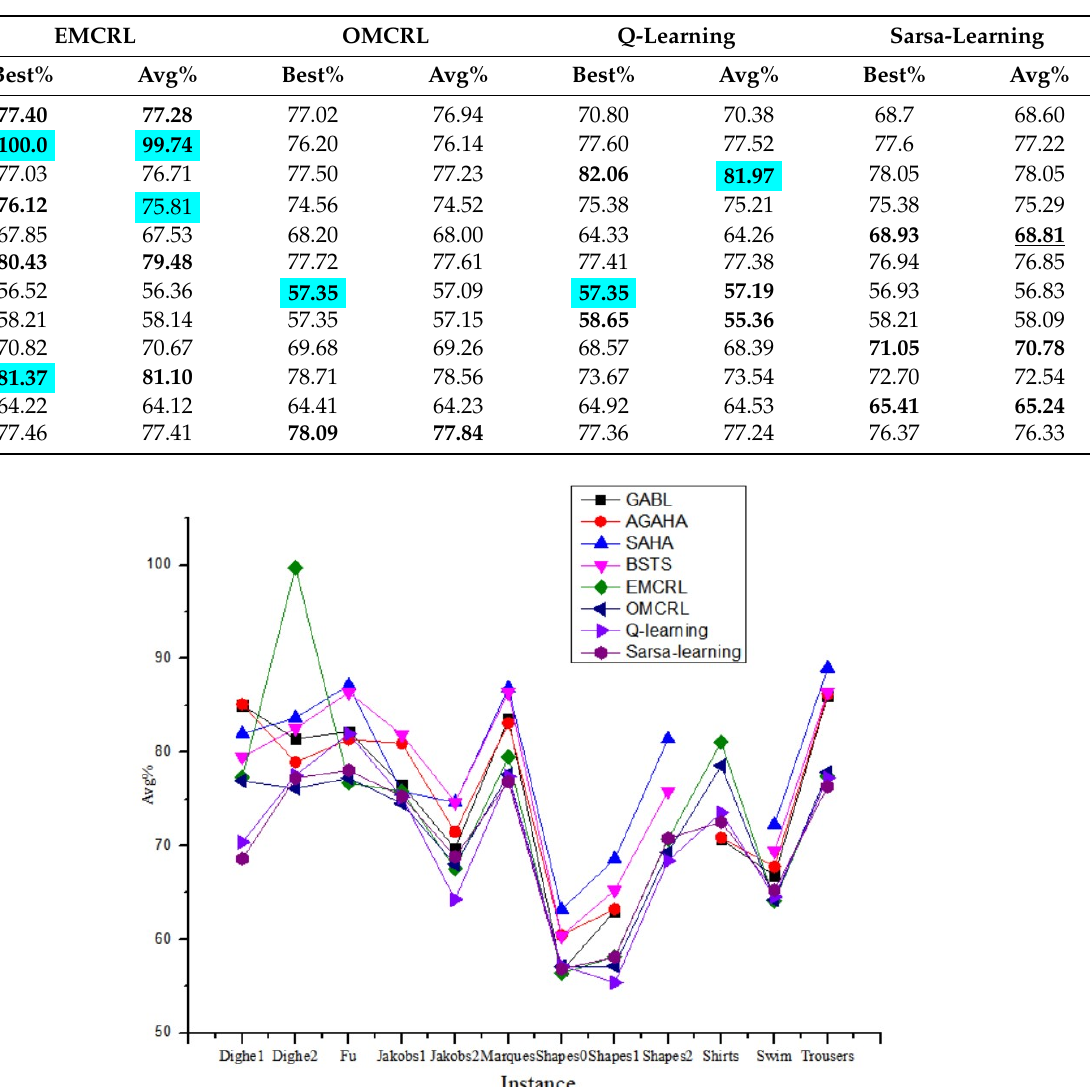
Table 4. Results for piece packing of hybrid RL.